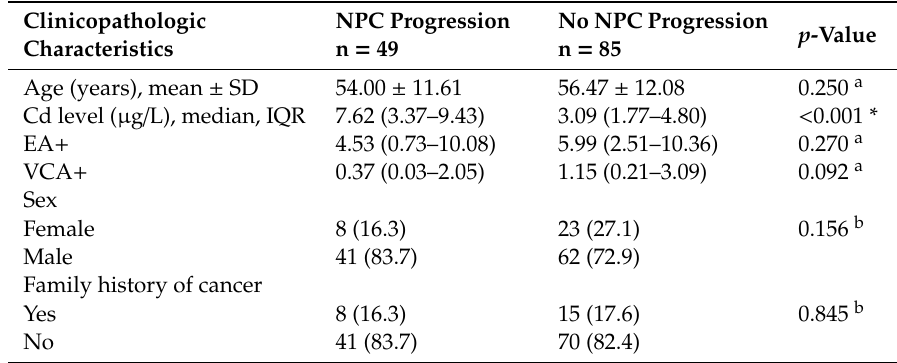
Table 1. Clinicopathologic characteristics of the participants with and without nasopharyngeal carcinoma (NPC) progression (n =